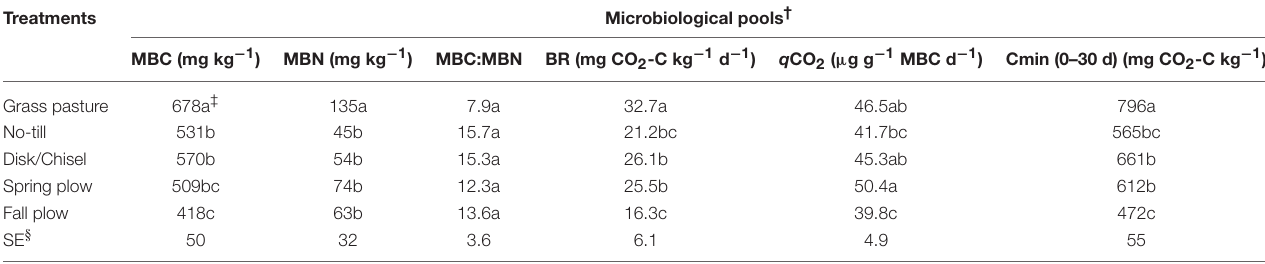
TABLE 3 | Treatment effects on microbiological pools of SOM in surface 0- to 15-cm Walla Walla silt loam near Pendleton, Oregon. Treatments Microbiological pools